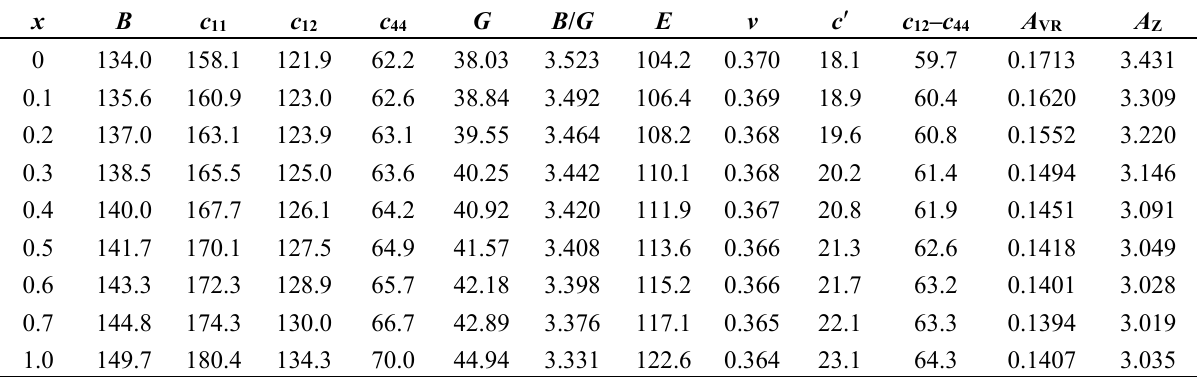
Table 2. Theoretical elastic constants c 11 , c 12 , c 44, c ʹ (units of GPa), polycrystalline elastic moduli B , G , E (unit of GPa) as well as the B/G ratio, the Zener ratio A z , the elastic anisotropy ratio A VR , the Poisson’s ratio v and Cauchy pressure ( c 12 – c 44 ) (unit of GPa) for the